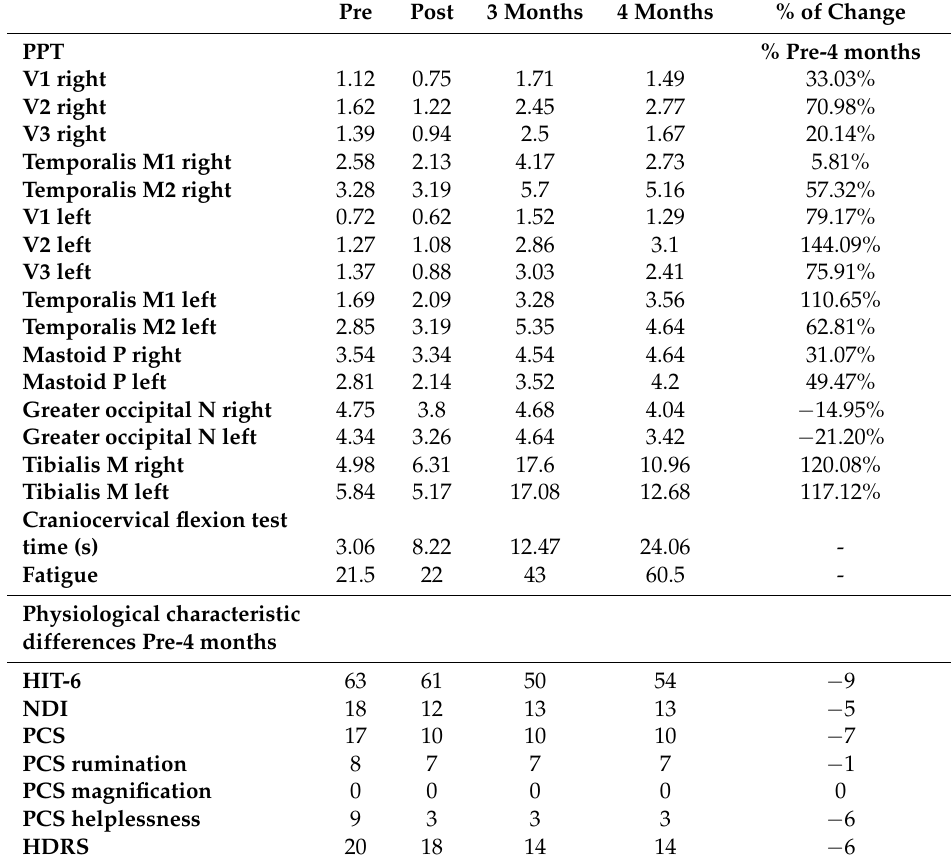
Table 1. Data and % of change of physical variables and psychological